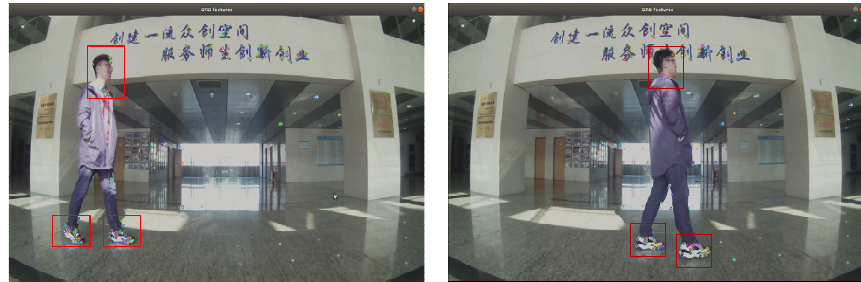
Figure 12. Location loss analysis.